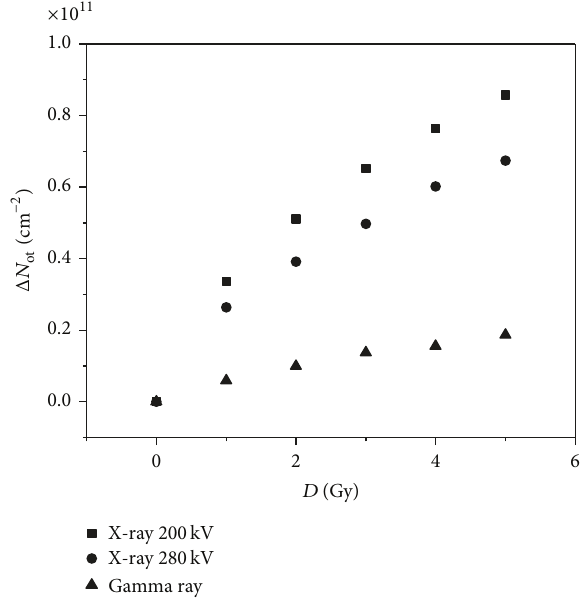
Figure 8: Δ𝑁 during 200kV and 280 kV X-ray as well as gamma- ot ray irradiation with zero gate bias.